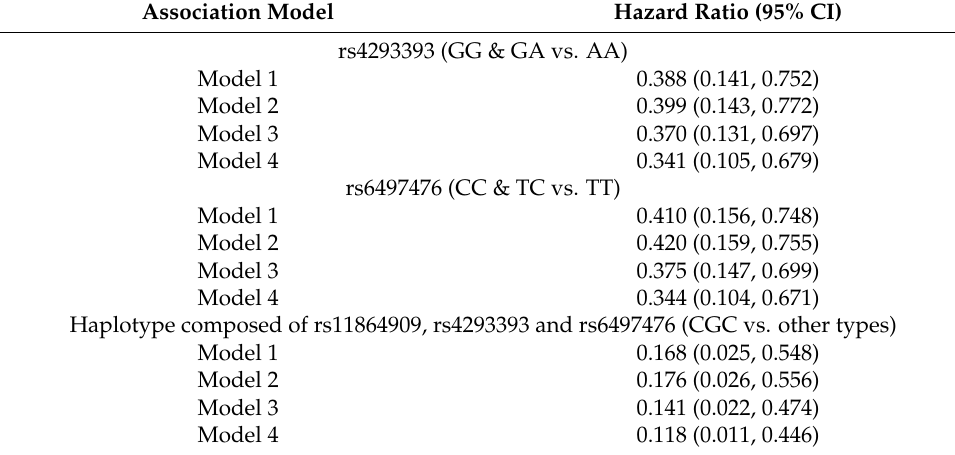
Table 4. Association between genotypes of rs4293393 and rs6497476 and haplotypes involving the variants and all-cause